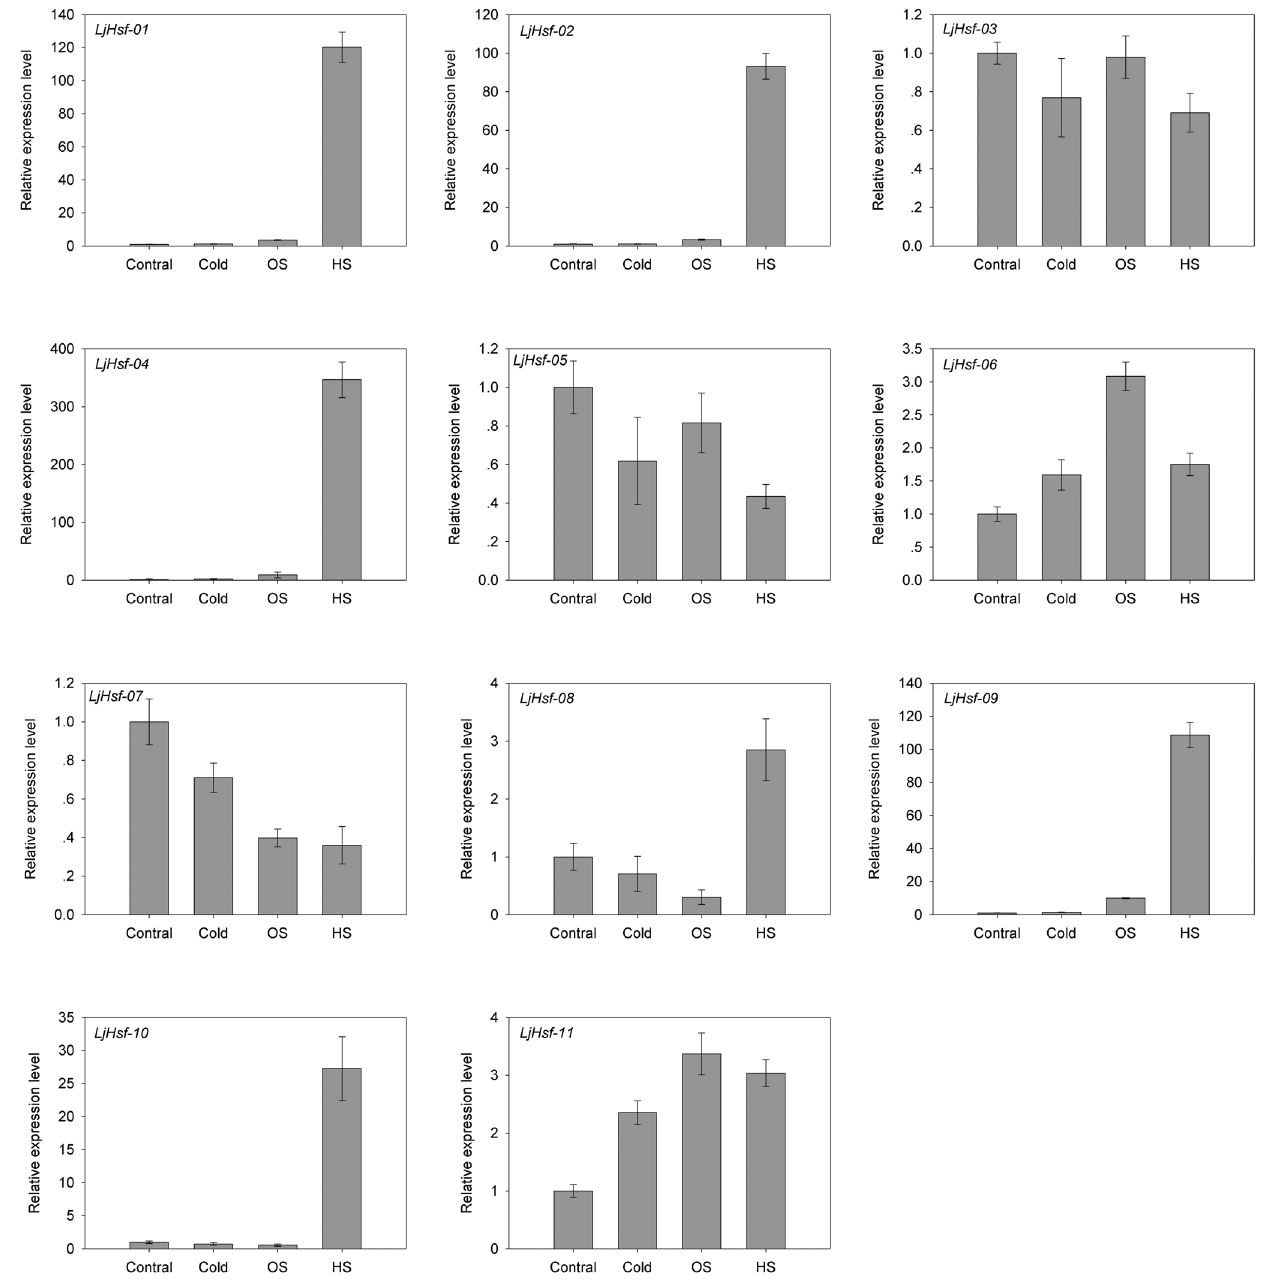
Figure 8. Expression of L.japonicus Hsf genes in response to abiotic stress measured by quantitative real-time PCR. The mRNA level of each gene in L. japonicus seedlings given heat (HS: 42 u C), cold (4 u C) and oxidative (OS: 10 mM H 2 O 2 ) stress for 1 h was plotted relative to the value obtained for the unstressed contral. Error bars represent standard errors.